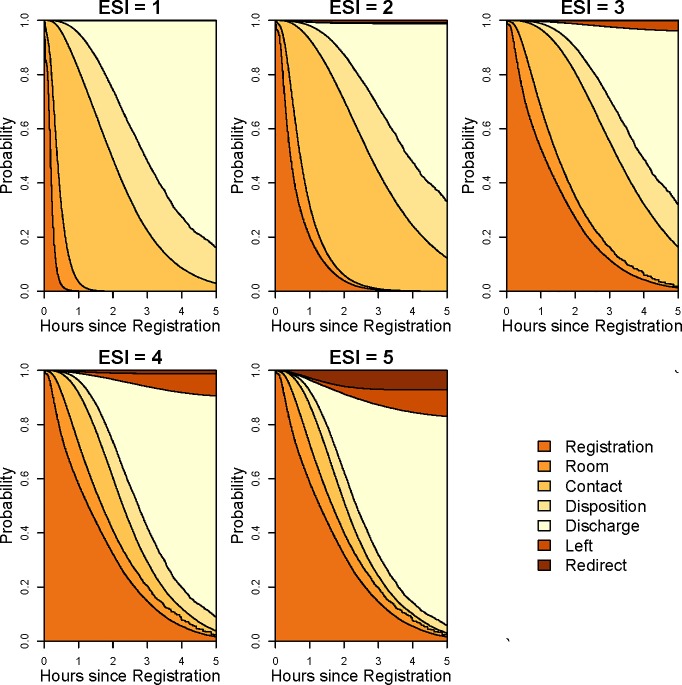
Stacked transition probabilities of the ED multistate model for different acuity (ESI) levels.Transition probabilities are conditional on age = 1 year, gender = male, ethnicity = not Hispanic or Latino, race = white, time of the day = 16:00–20:00, season = winter, and number of ED physicians = 8.